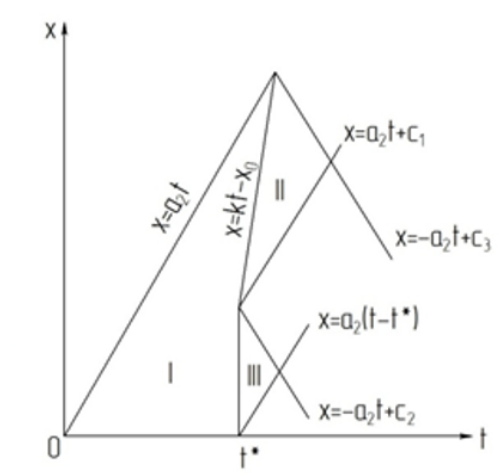
Fig. 5a. The geometric interpretation characteristics.